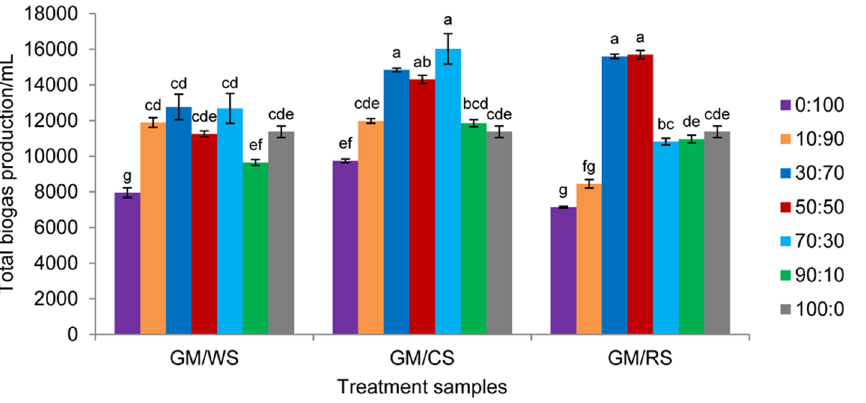
Figure 3. Total biogas productions from anaerobic co-digestion of GM with WS, CS and RS with different mixing ratios. Mean values originated from three independent replications. Vertical bars represent standard deviations. The ANOVA test was conducted to determine the differences between each cultivar. Values with the same letters indicate no significant difference at P , 0.01.